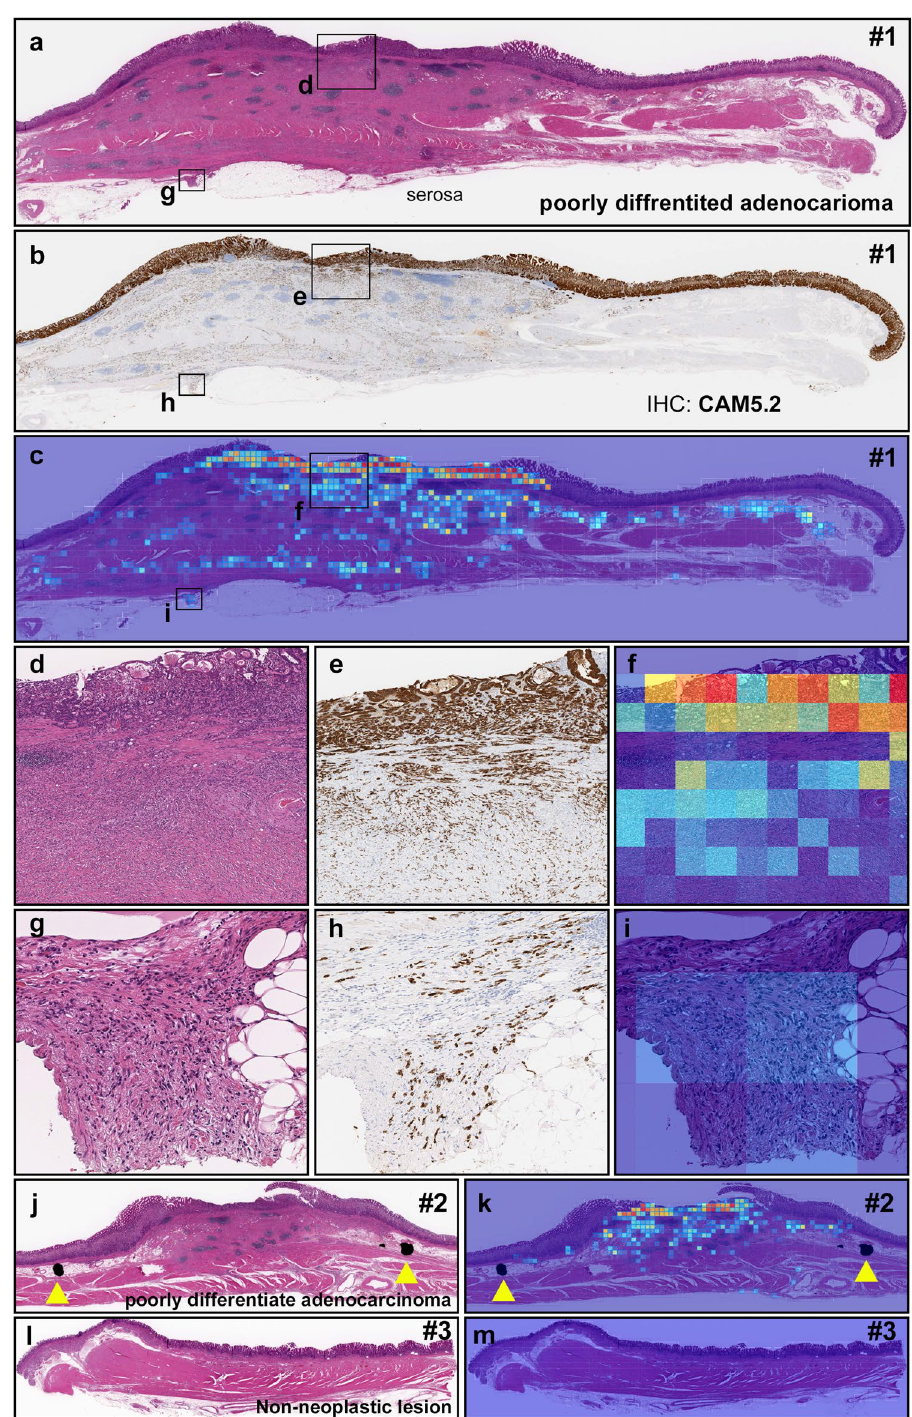
Figure 6. A representative surgically resected case serial specimens for diffuse-type differentiated ADC. Serial specimens: #1 ( a – i ), #2 ( j , k ), and #3 ( l , m ). In #1 ( a ), diffuse-type differentiated ADC cells which are positive for CAM5.2 ( b , e , f ) invaded from submucosa ( d , e ) to subserosa ( g , h ). ( c , f , i ) show true positive probability heatmaps for invading diffuse-type differentiated ADC. In #2 ( j ), true positive probability heatmap image for invading diffuse-type differentiated ADC ( k ) cell invading area was corresponded to surgical pathologists marked area with ink-dots (yellow-triangles) ( j ). #3 ( l ) is a non-neoplastic tissue without any sign of cancer cell invading which is corresponded to the heatmap image ( m ). Model applied at × 20, where the 224 × 224px 2 heatmap square represents 112 × 112 µ m